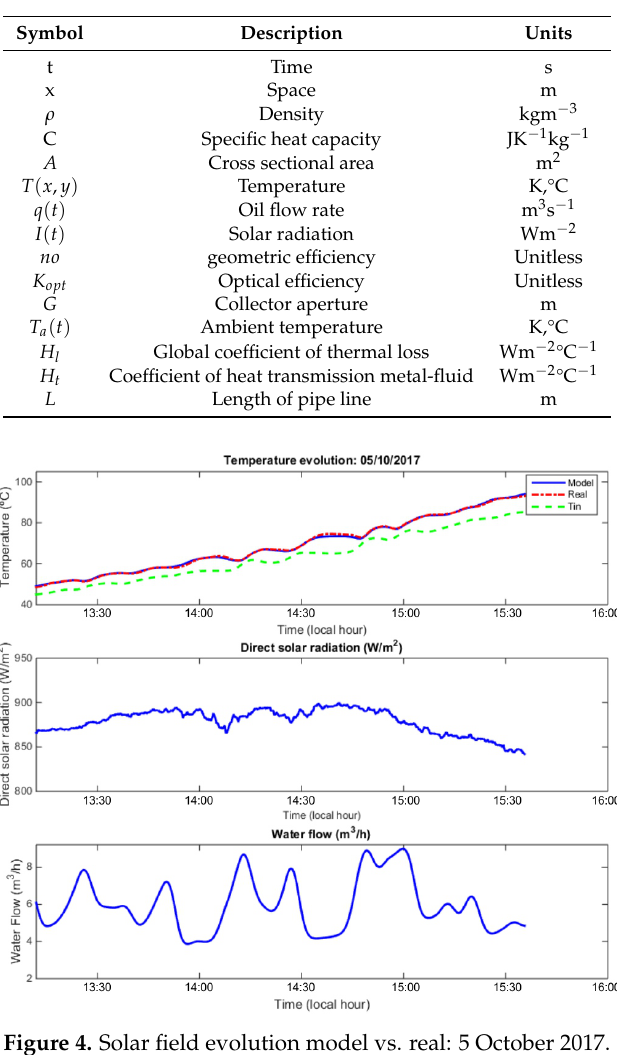
Figure 4. Solar field evolution model vs. real: 5 October 2017.